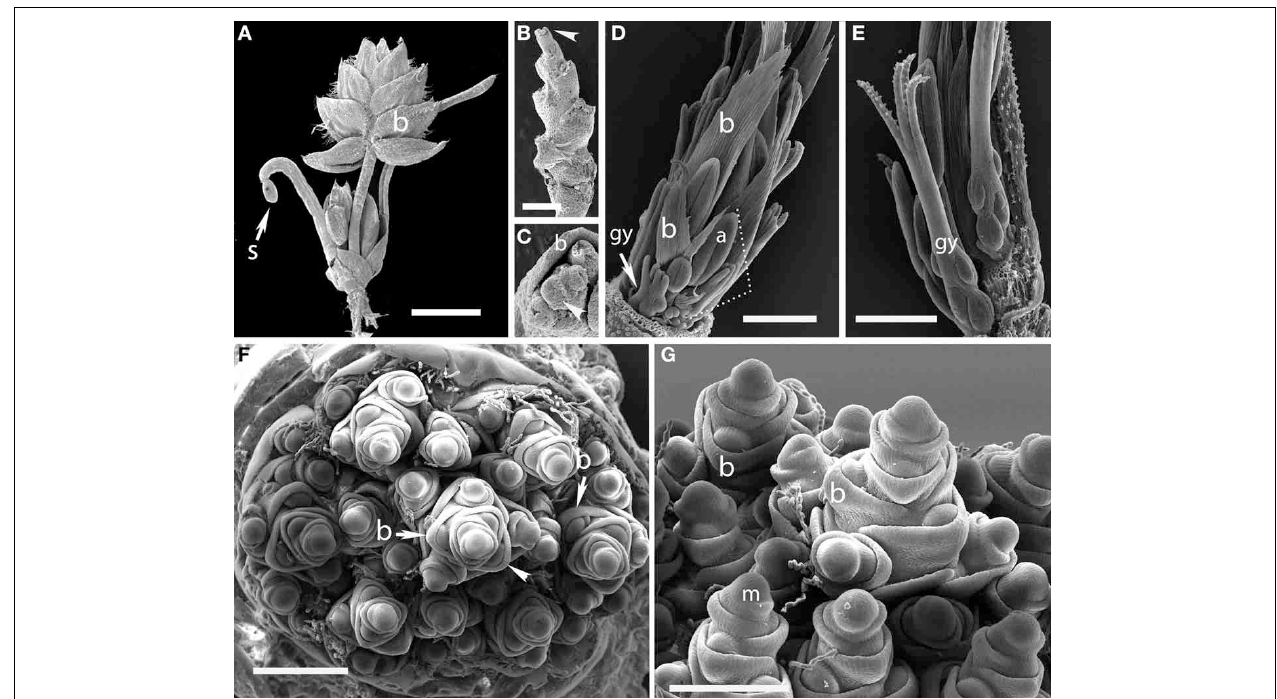
indicate one floral unit. ( F,G) Joinvillea ascendens , showing spiral phyllotaxis; it is unclear at this stage of development whether the meristems will develop into branches or spikelets. b, bract; gy, gynoecium; a, anther; m, meristem; s, seed coat. Arrow head in (B) indicates region enlarged in (C) . Scale bars: (A) , 3mm; (B) , 1mm; (D–F) , 500 µ m; (G) , 400 µ m.